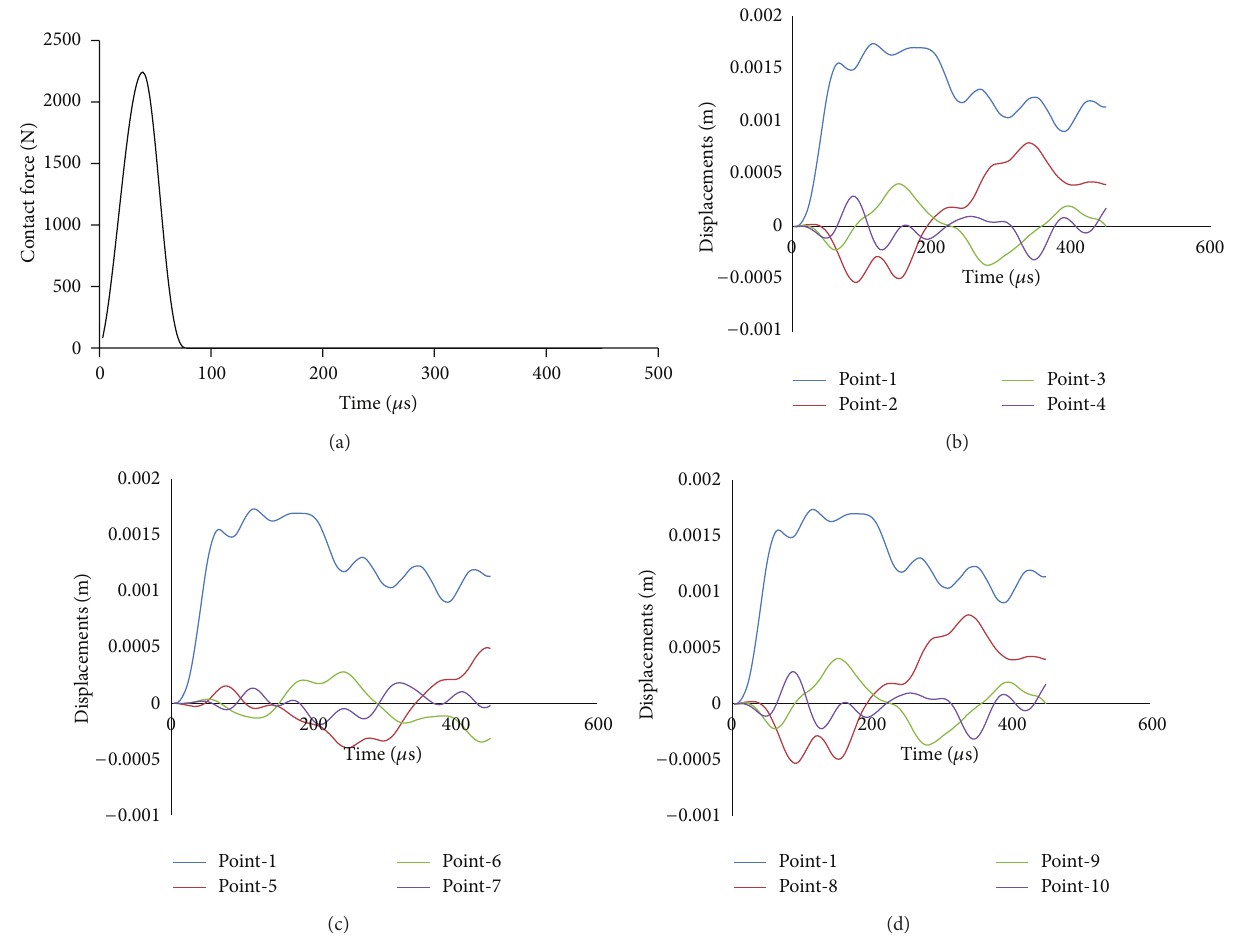
Figure 7: Impact response of clamped cross ply (CL/CP) composite hypar shells for impact velocity